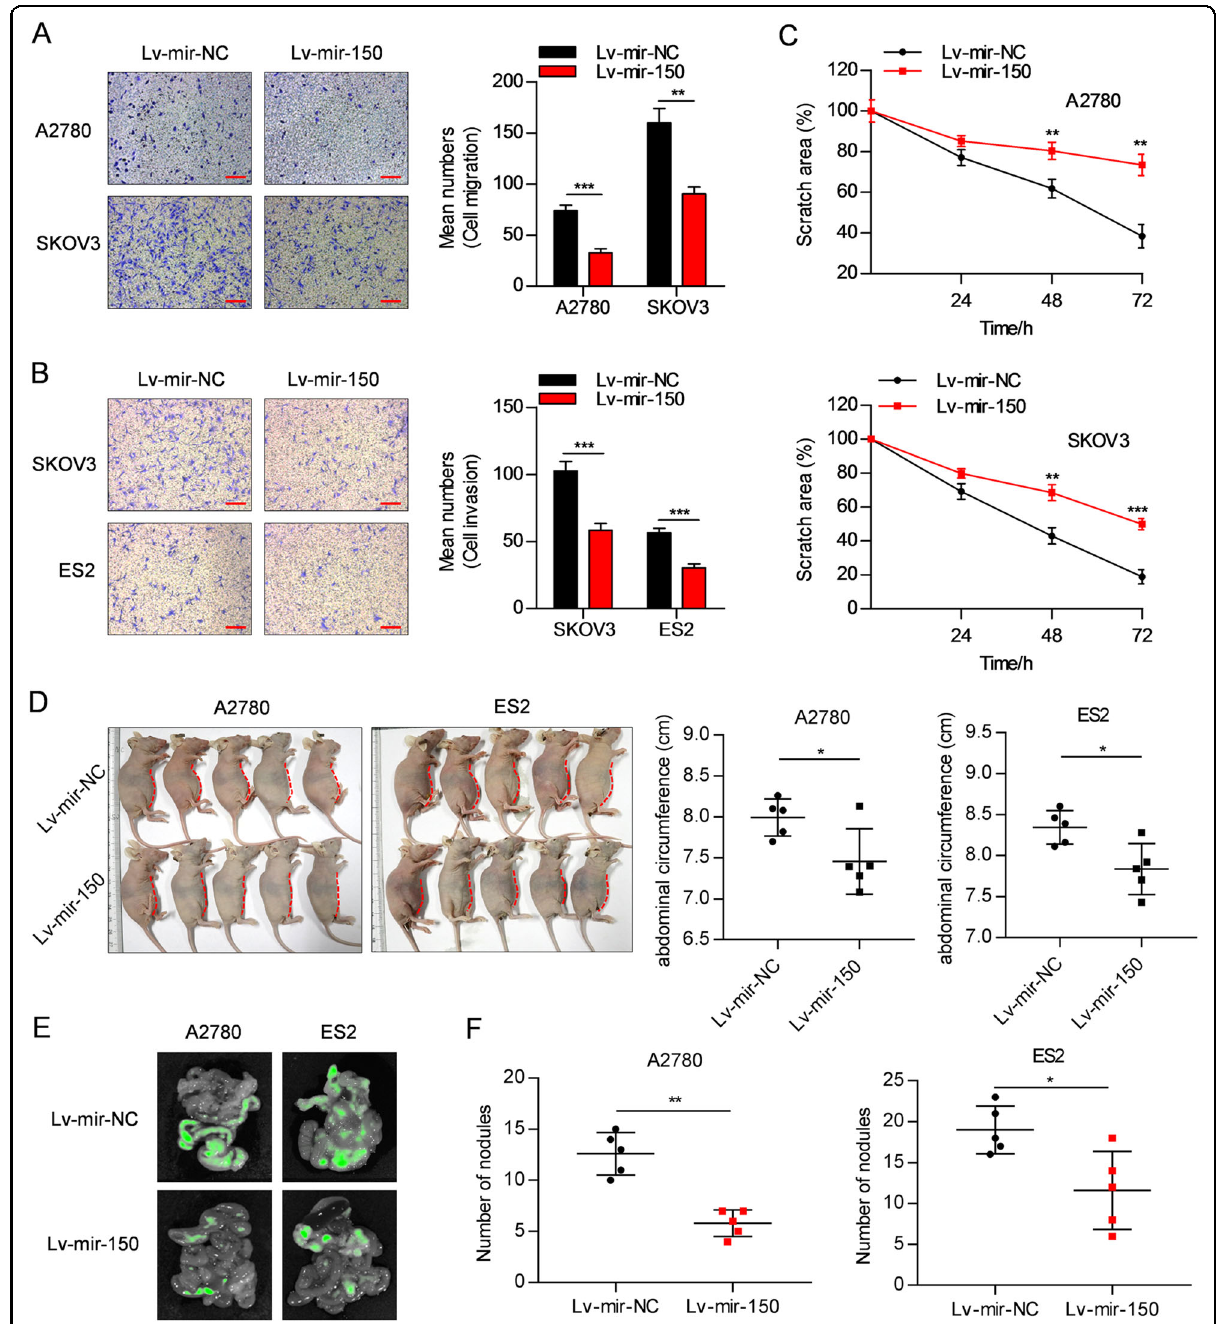
Fig. 3 miR-150 inhibits migratory and invasive ability of OC cells in vitro and in vivo. A , B Stably overexpressing miR-150 reduced migration ( A ) and invasion ( B ) of OC cells in vitro. Scale bar: 200 µm. C Wound healing assay indicated that miR-150 overexpression inhibited healing ability of A2780 (top) and SKOV3 (bottom) cells. D – F Lv-mir-150 OC cells and corresponding Lv-mir-NC cells were intraperitoneally injected into female BALB/c nude mice that were euthanized after 45 days (for A2780 cells) or 24 days (for ES2 cells) ( n = 5). D Images showing smaller ascites volumes (left) and abdominal circumference (right) in mice injected with Lv-mir-150 cells than those in control cells. E Fluorescence imaging revealed that mice injected with Lv-mir-150 cells had weaker green fl uorescence signals on the mesentery. F Number of nodules was signi fi cantly lower in mice injected with Lv-mir-150 cells when compared with that of the control group. The data are presented as the mean ± s.d. * P < 0.05, ** P < 0.01, *** P < 0.001 by Student ’ s t